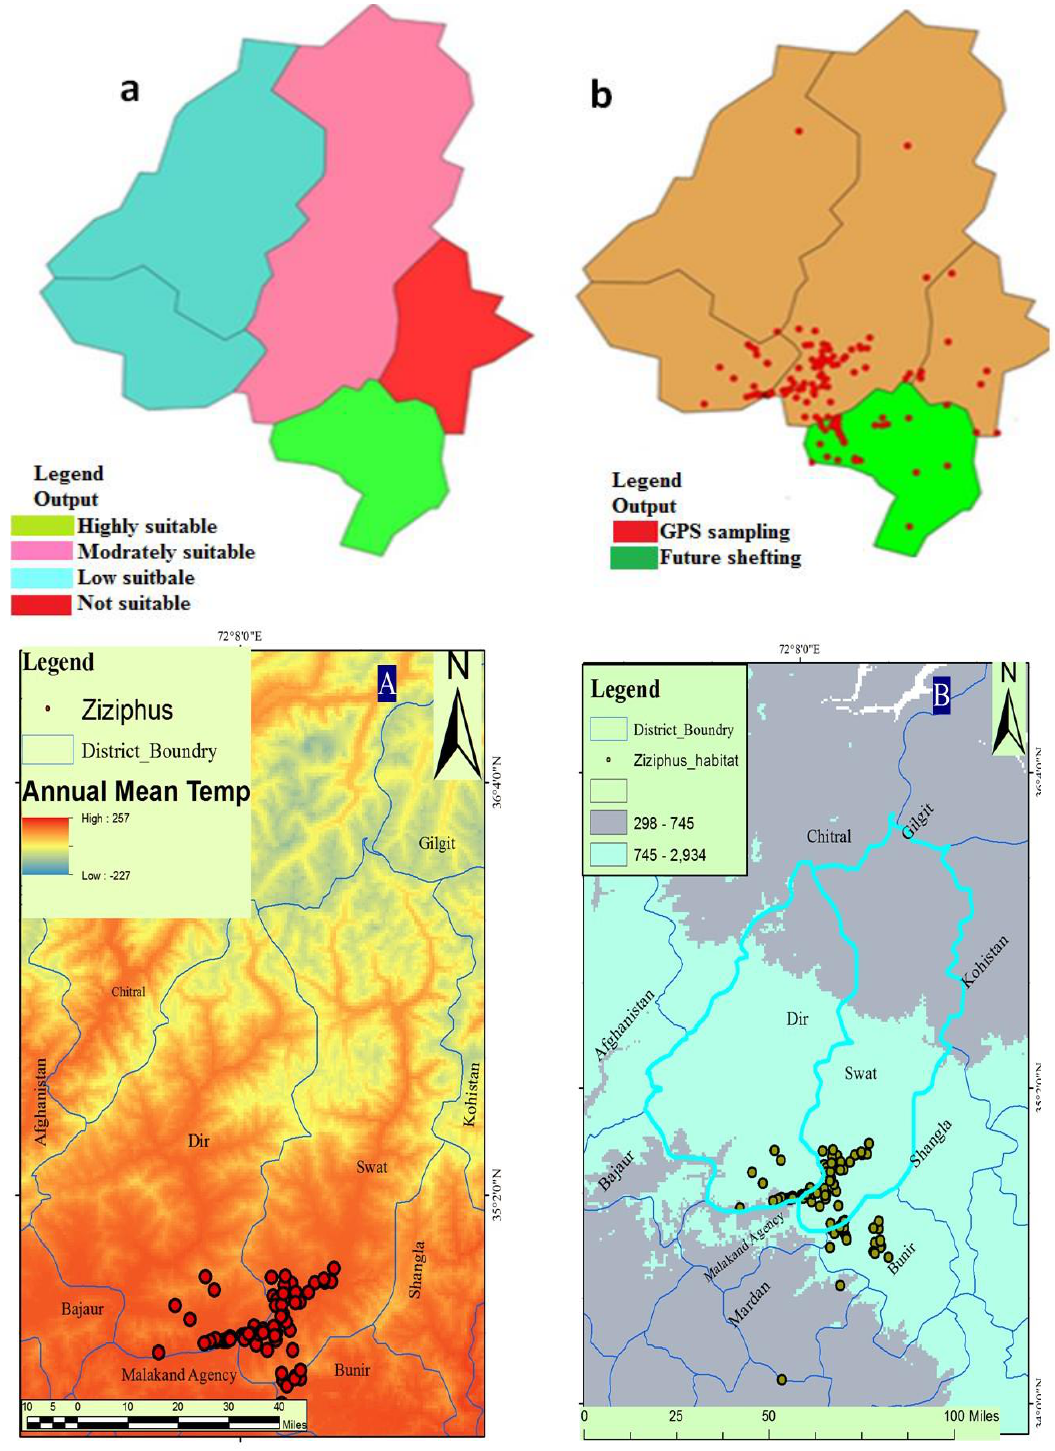
Figure 2. Showed that the ArcGIS mapping of a bioclimatic variable on the selected regions, ( a and b) designated for the suitable distribution regions of Ziziphus nummularia ( A ), annual mean temper- ature and ( B ), annual precipitating. perature and ( B ), annual